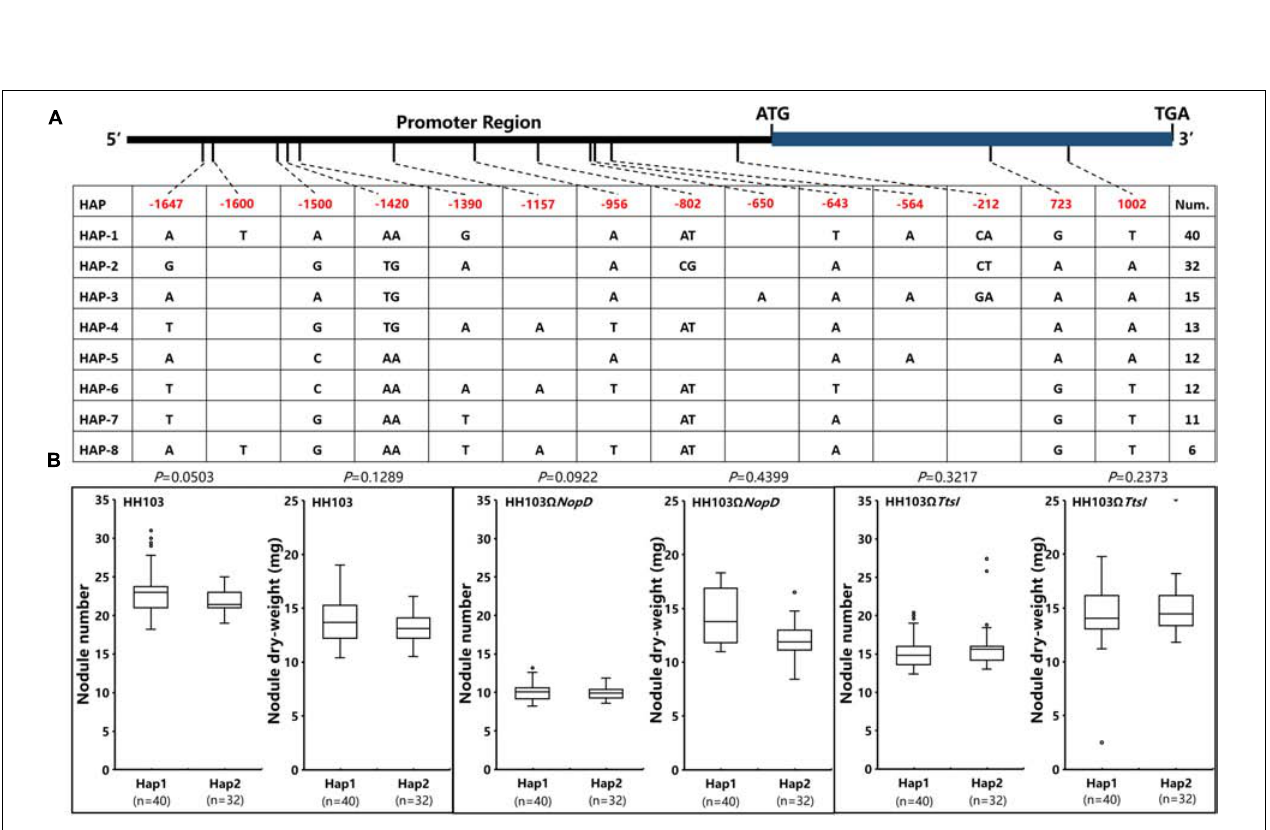
FIGURE 6 | The analysis of Gm19g068600 haplotypes and nodule traits in two Hap accessions. (A) Gm19g068600 gene haplotypes (eight haplotypes) in chromosome segment substitution line (CSSL) populations ( n = 142). The start codon site is set at “0” position. (B) Comparison and analysis of the nodule phenotype between haplotypes Hap1 ( n = 40) and Hap2 ( n = 32). n represents the number of the two haplotypes. Two-tailed t -test was used to detect the significance.